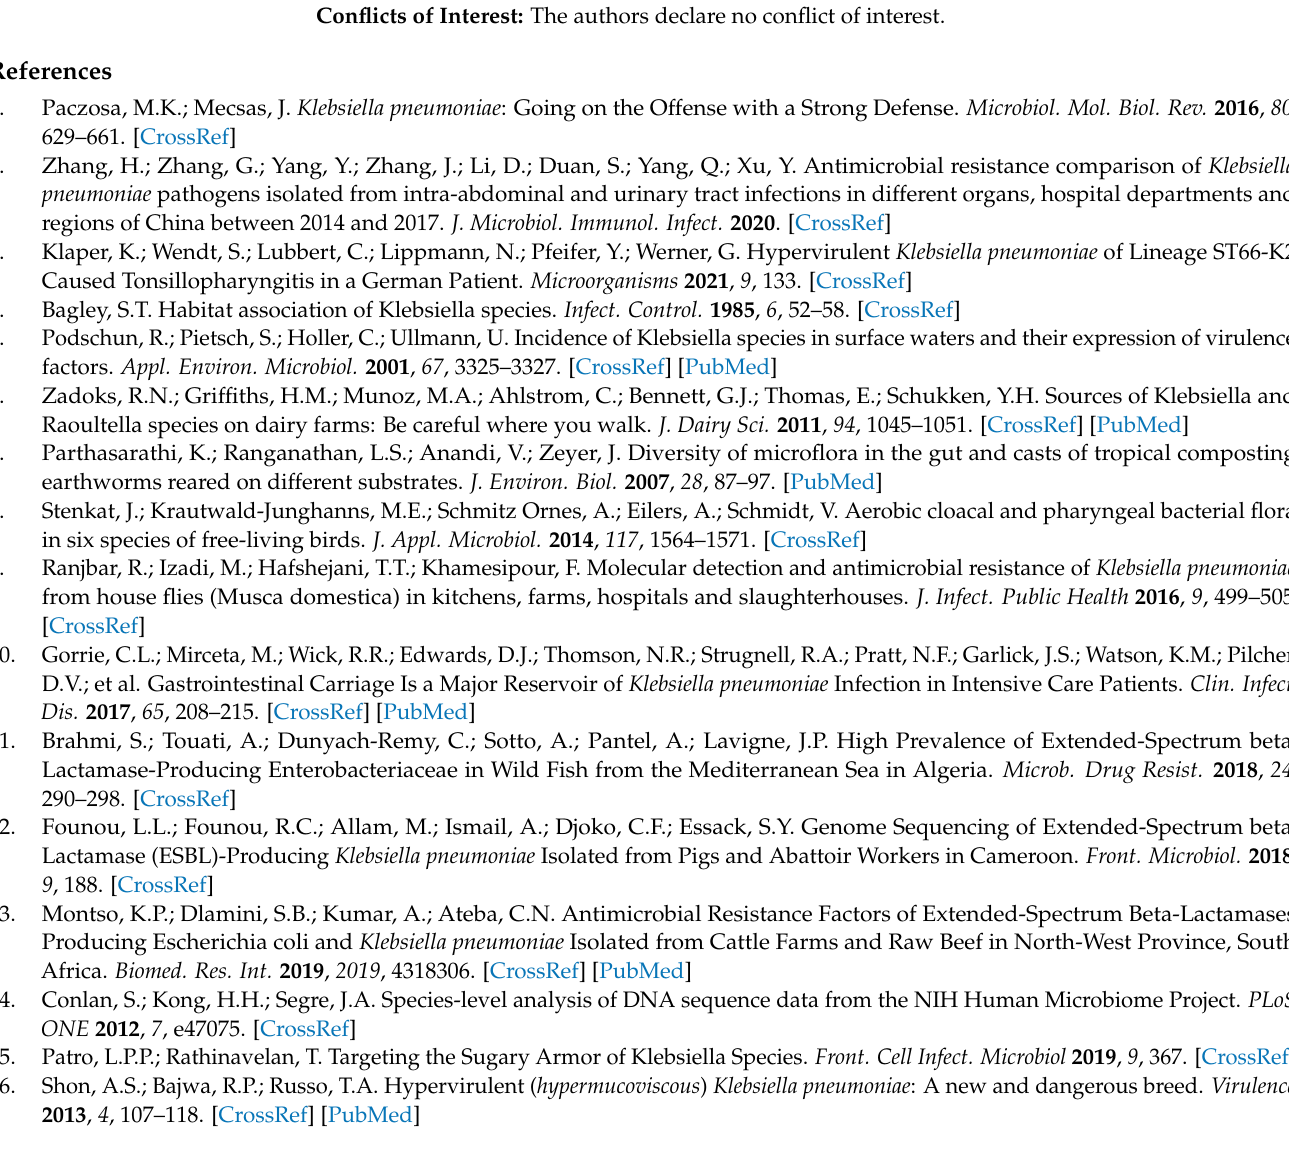
the string test, Table S1: Bacterial strains and plasmids used in this study, Table S2: Oligonucleotide primers used in this